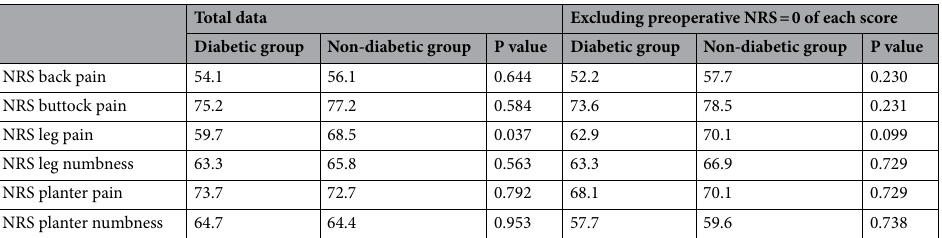
Table 4. Comparison of rates (%) of achievement of 50% relief in pain/numbness between the two groups. The values are given as the percentage in each group. Each P value was calculated by chi-square test. CI, confidence interval; NRS, Numerical Rating